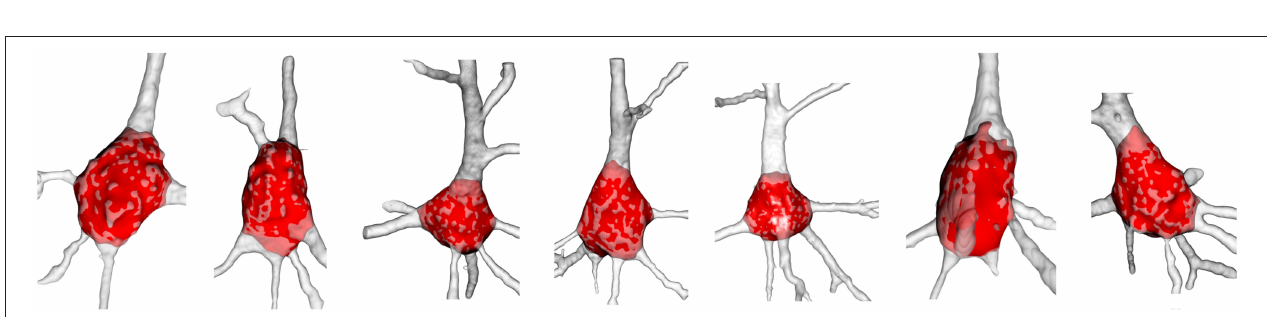
FIGURE 6 | (A) Histogram and first clustering. The charts represent the volume distribution of the soma and the apical dendrite (red) and the basal dendrites (green) of the neurons shown in Figure 2 . There are clearly two Gaussians. (B) Histogram and second clustering. The charts show the volume distributions in the vicinity of the soma (red) and the apical dendrite (green) of the outcome of the first clustering. The graphs columnwise represent the same cell along the process. There are also two Gaussians in these new graphs, demonstrating that the apical dendrite was hidden. This clustering removes the vertices of the apical dendrite in some cases, as in the second chart, and improves the accuracy of the cutoffs in other cases, as in the fourth chart.